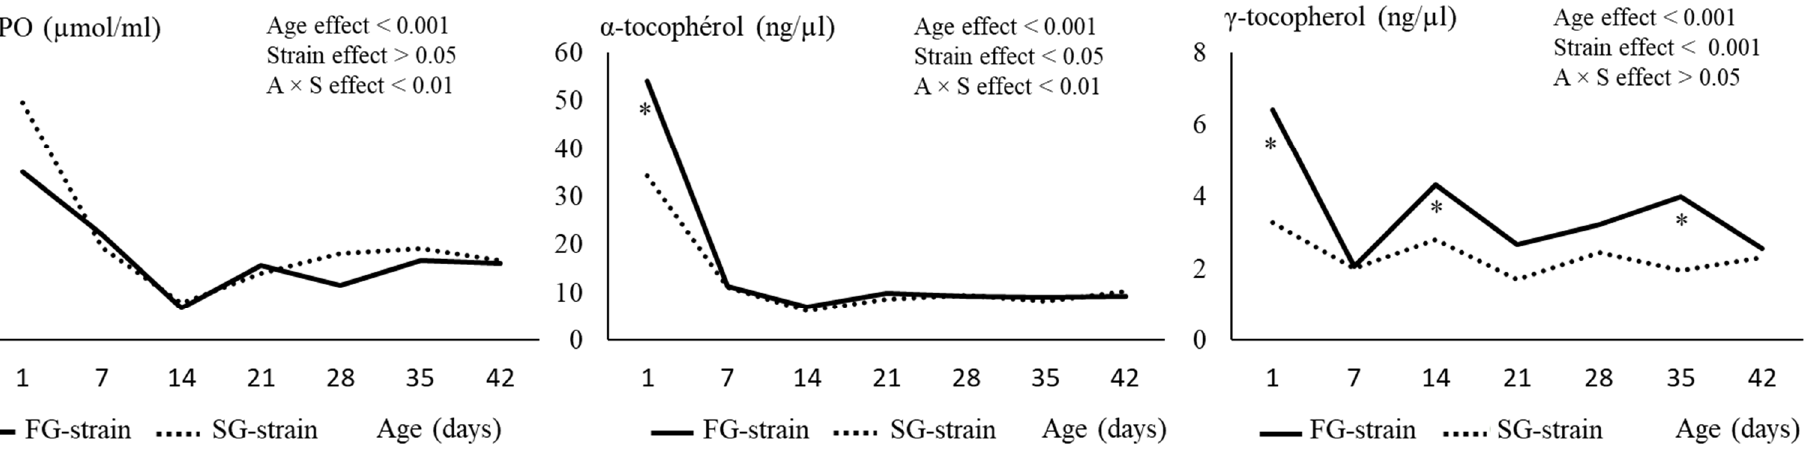
Figure 3. Effects of age (A) and strain (S) and their interaction on plasma hydroperoxides (HPO) and α - and γ -tocopherol content. Data are presented as the means; n = 10 per strain and per age. *: Significant difference ( p < 0.05) between strains for a given age; FG = fast-growing, SG = slow-growing.